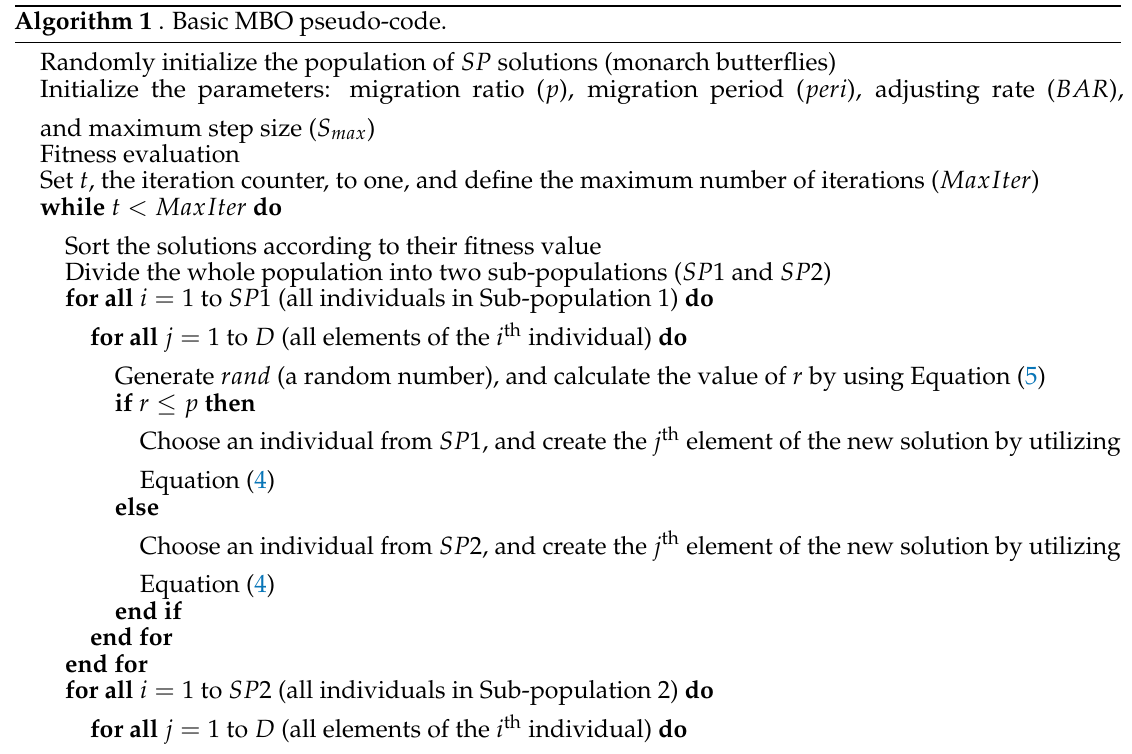
Algorithm 1 . Basic MBO